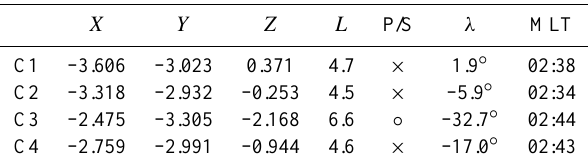
Fig. 3: EFW probe potential on 21 January 2003.